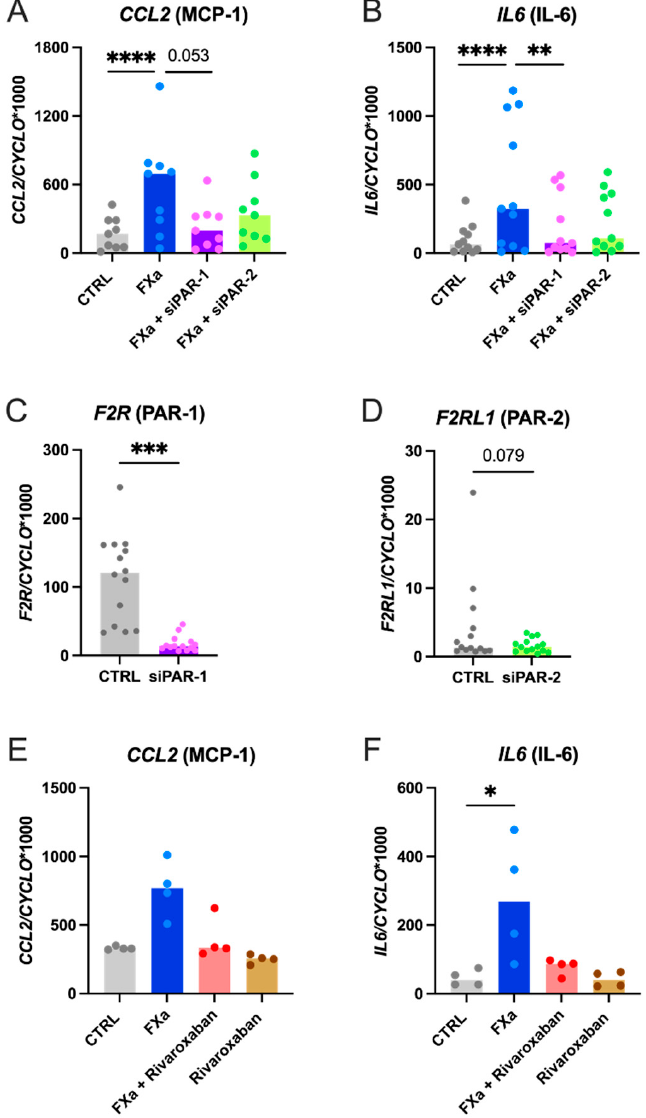
Figure 4. Effect of PARs silencing on FXa-mediated CCL2 and IL6 expression in human CFs ( A , B ; n = 8–9). Before exposure to FXa (100 nM), human atrial CFs were transfected with 10 µM of either scrambled F2R (PAR-1) or F2RL1 (PAR-2) specific siRNA and incubated for 48 h. Gene expression was measured by RT-qPCR after 4 h of incubation with FXa. Data were normalized to the housekeeping gene Cyclophilin-A. Statistical analysis was performed using the non-parametric Friedman test for paired samples ( CCL2 : overall p < 0.001; IL6 : overall p < 0.001) and Dunn’s multiple comparison test (**p < 0.01, ****p < 0.0001) . Effect of silencing on F2R (PAR-1) and F2Rl1 (PAR-2) gene expression ( C,D ; n = 14). Data were analysed using the non-parametric Wilcoxon test for paired samples ( ***p < 0.001 ). Effect of FXa inhibition by rivaroxaban on CCL2 and IL6 expression in human CFs ( E,F ; n = 4). Statistical analysis was performed using the non-parametric Friedman test for paired samples ( CCL2: overall p < 0.001 ; IL6: overall p < 0.001) and Dunn’s multiple comparison test (*p < 0.05 ). Results are expressed as median bars, with dots indicating individual human CF isolations.